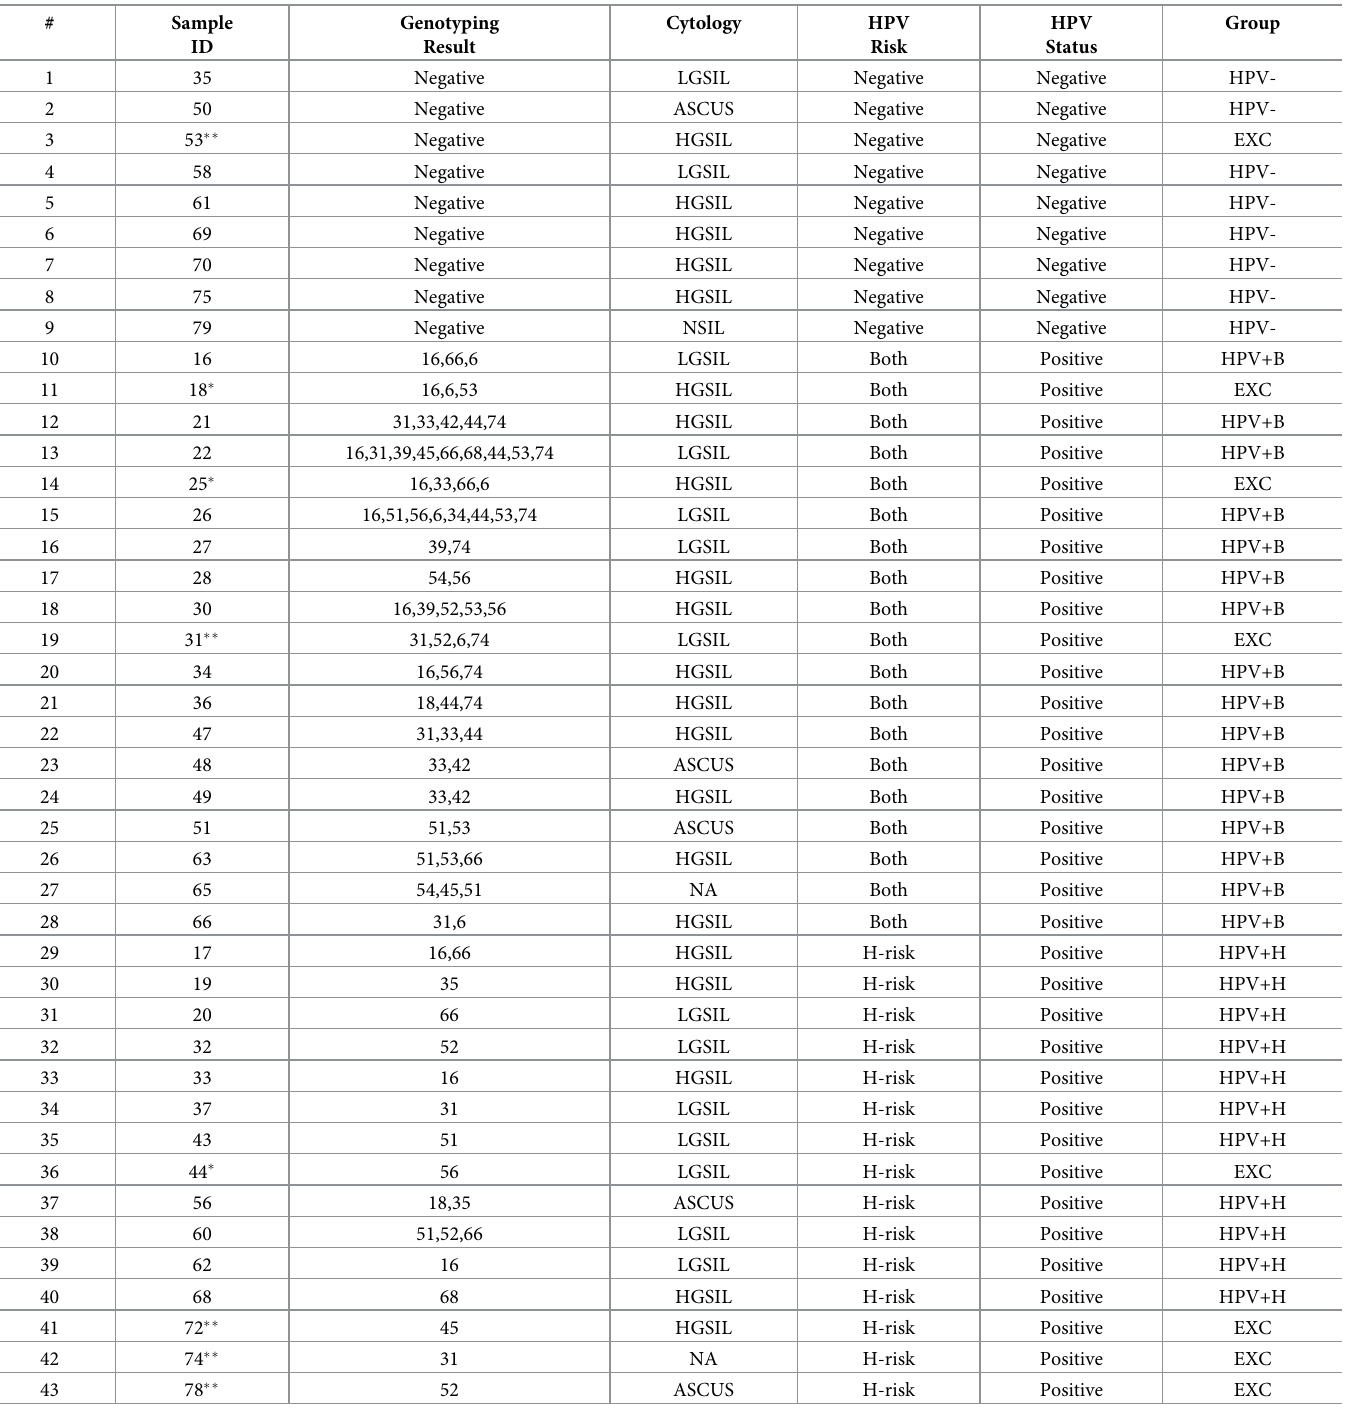
Table 1. Sample IDs and groupings by HPV-risk, genotypes and